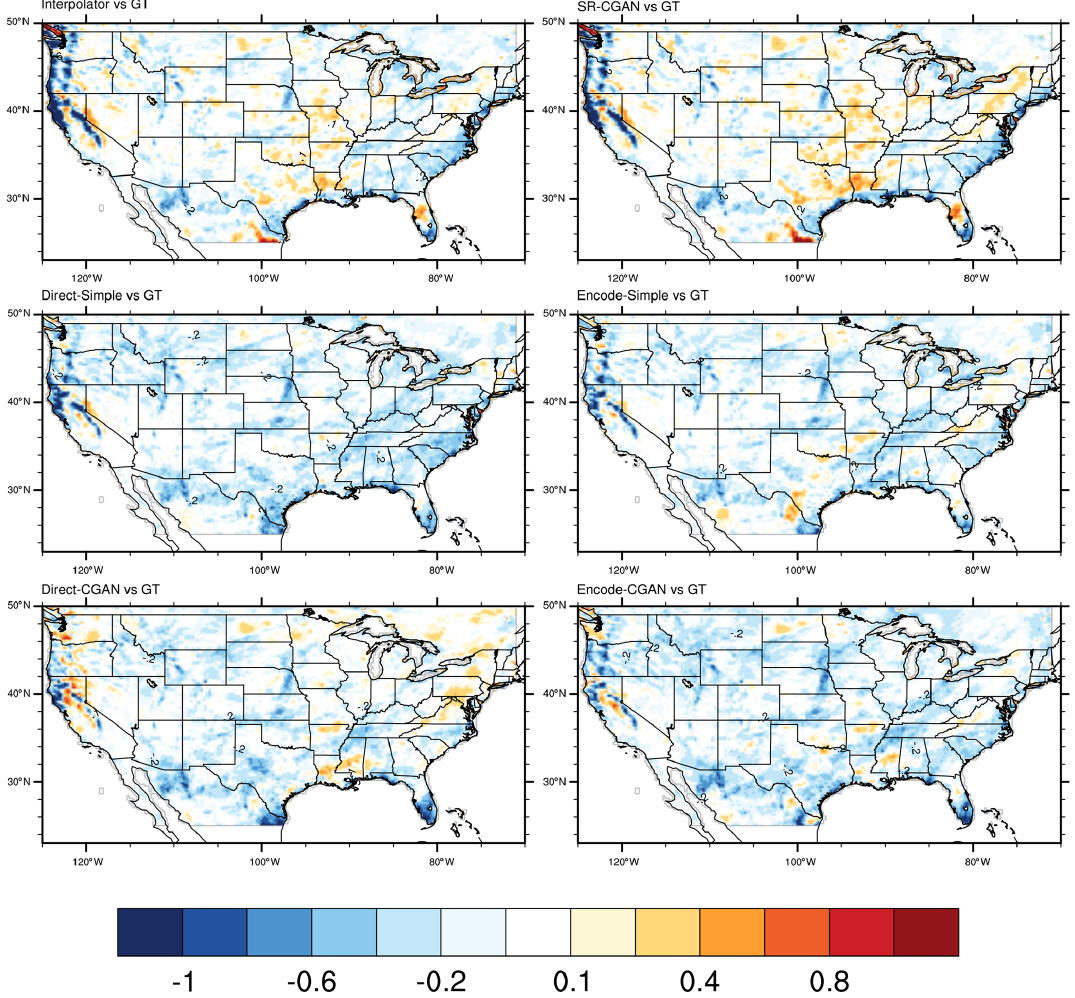
Figure 9. The differences (predictive models vs. Ground Truth) in standard deviation of precipitation (mm/3h) produced by Ground Truth, Interpolator, and five CNN models for the testing period